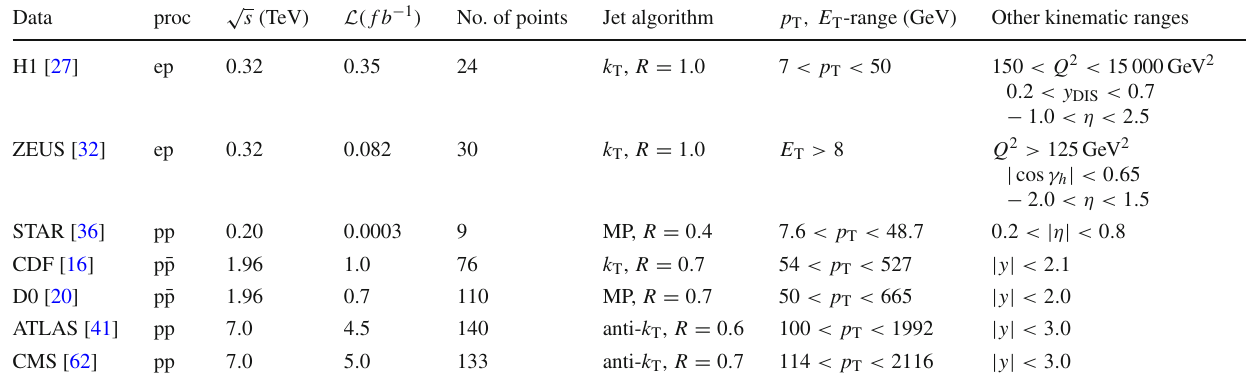
may be defined by the four-momentum transfer squared Q 2 , the inelas- ticity y DIS , or the angle of the hadronic final state | cos γ h | of the NC DIS process. In all cases, jets are required to be within a given range of pseudorapidity η or rapidity y in the laboratory